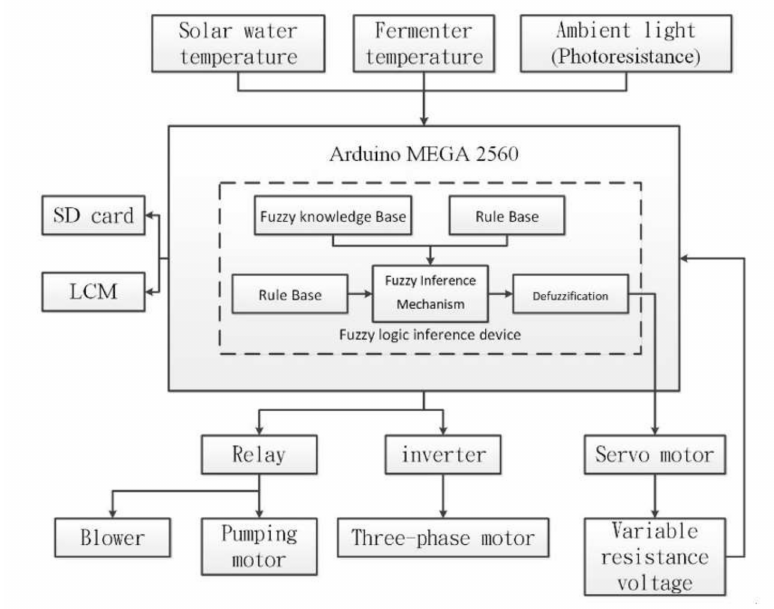
Figure 1. Master architecture diagram in control system.